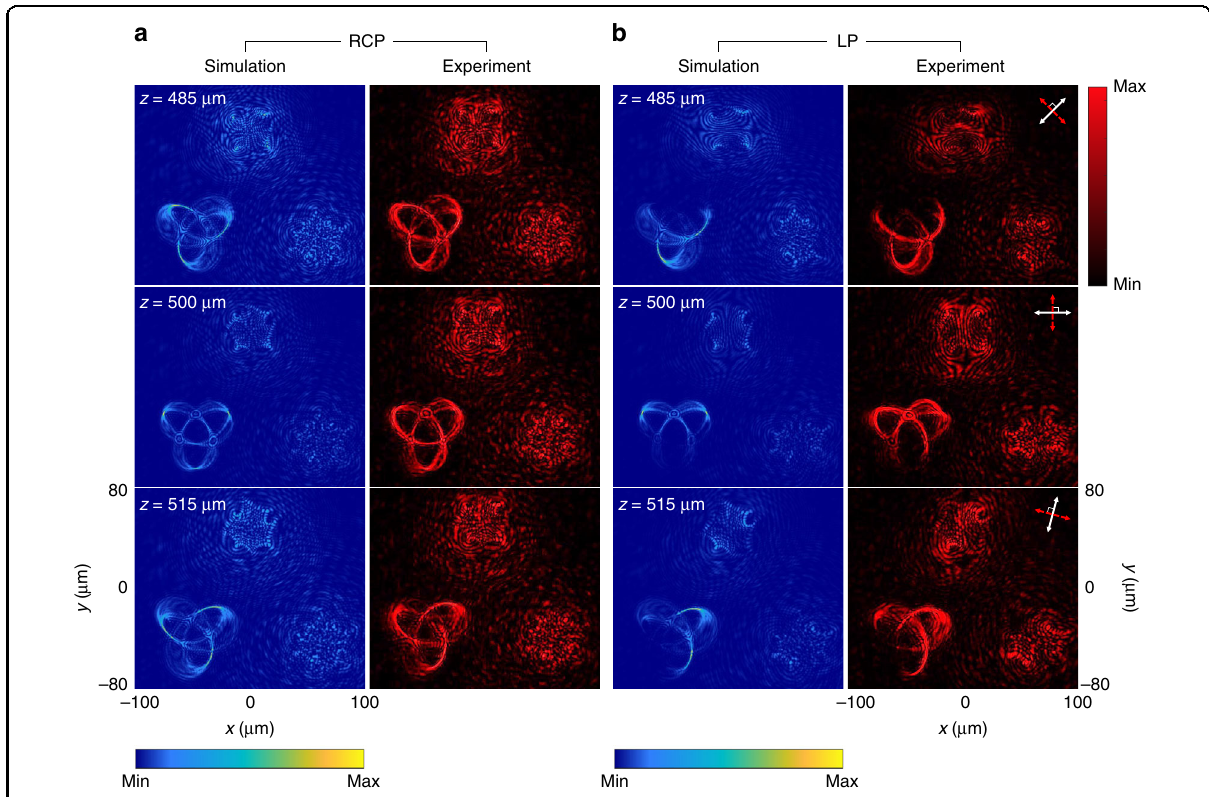
Fig. 4 Simulation and experimental results of the selected 3D polarization knots at λ = 650 nm. a The intensity distributions at different observation planes upon the illumination of RCP light. b The intensity distributions at different observation planes upon the illumination of an LP light beam for polarization distribution detection with different combinations of transmission axes of the linear polarizer and the analyzer. The direction of the white arrows: 45° ( z = 485 μ m), 0° ( z = 500 μ m), and 75° ( z = 515 μ m) w.r.t. the x